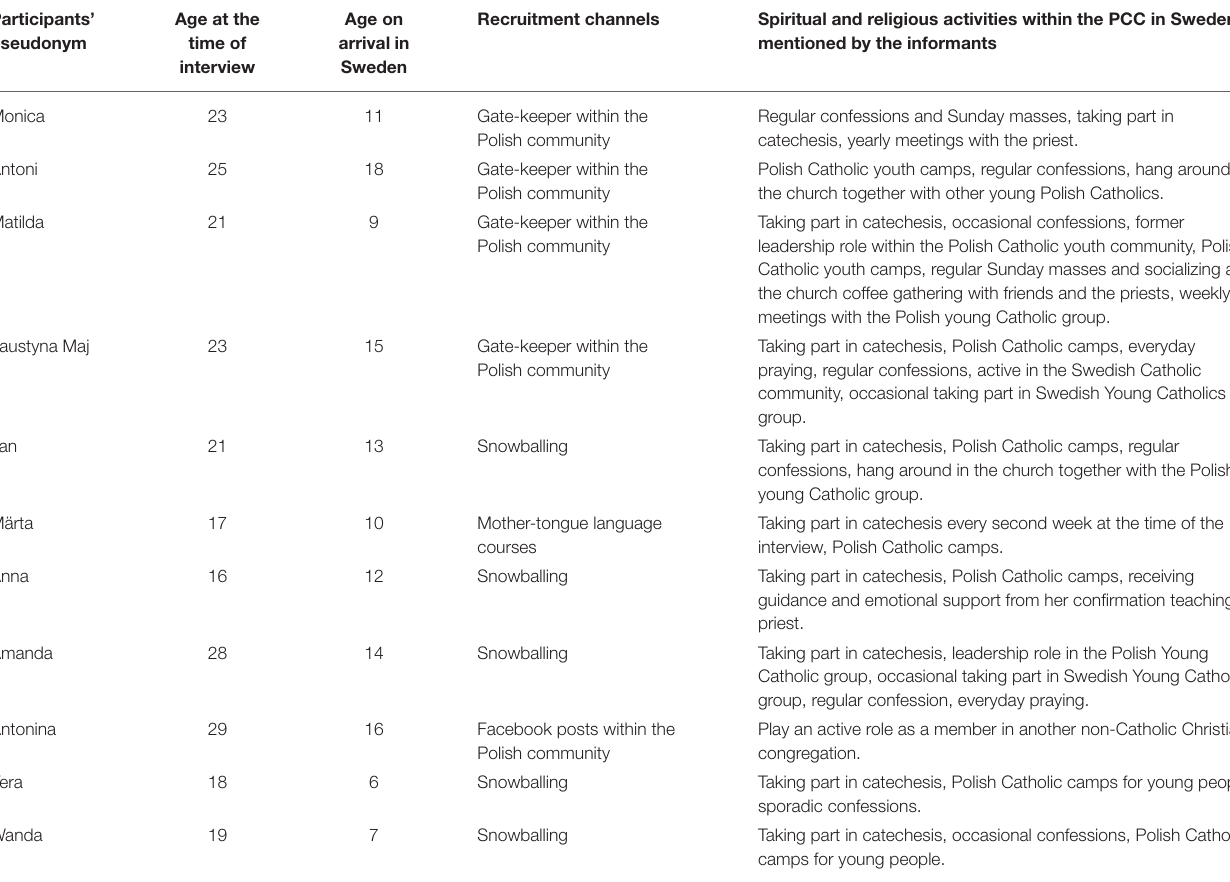
TABLE 1 | Polish-born research